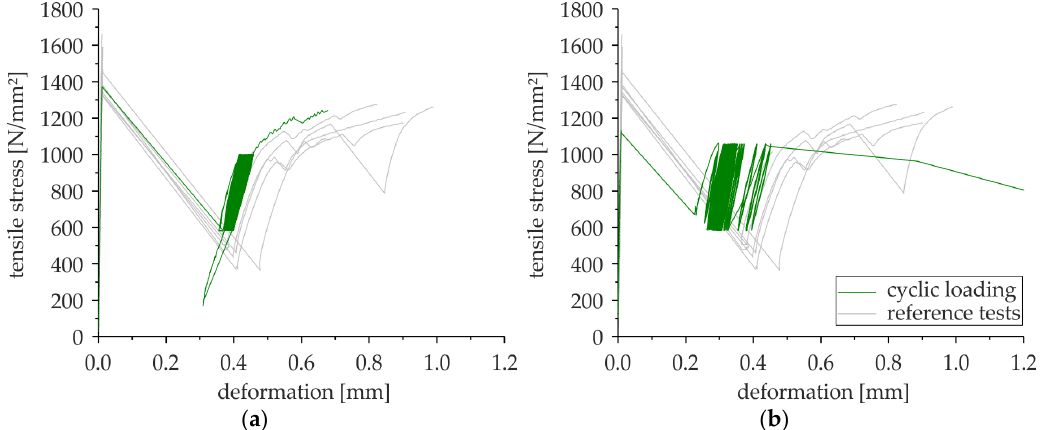
Figure A1. Cyclic stress–deformation curves (here: anchorage length = 1 a ): ( a ) non-failed specimen; ( b ) failed specimen (load cycles: 34323).